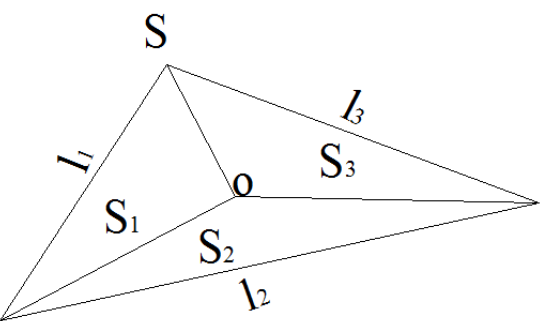
Figure 2. The model of the algorithm that fills triangles inside an STL file.